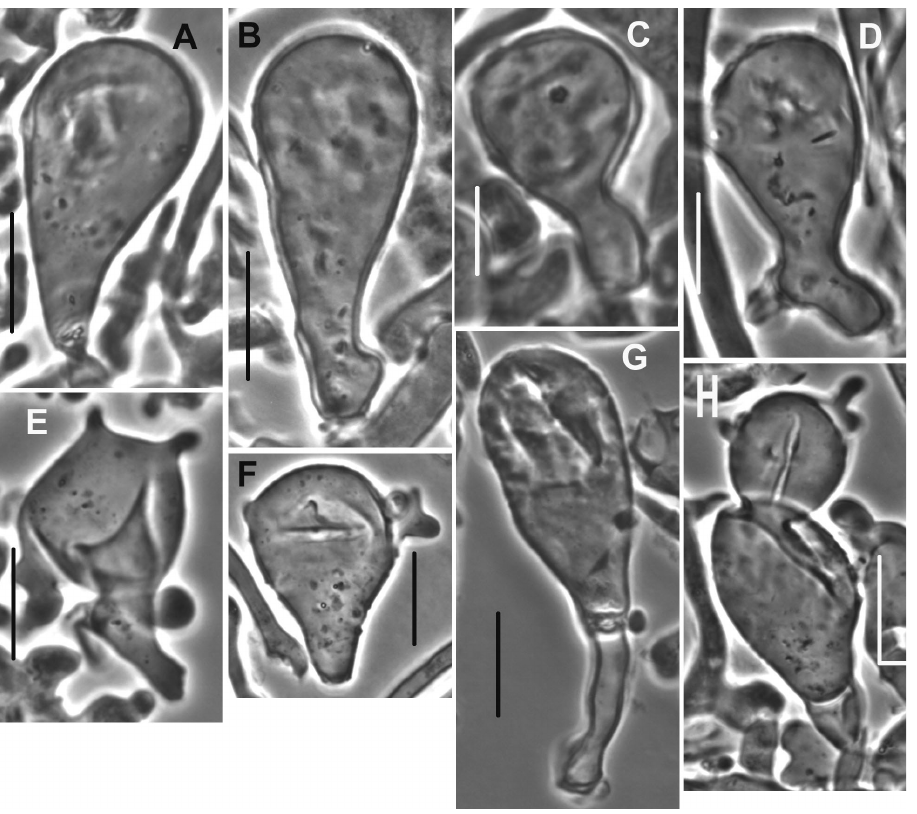
Figure 21. Mycetinis copelandii . Pileipellis elements. A–D, G Broadly clavate individuals without out- growths E, F, H Individuals with lobose outgrowths. Standard bars = 10 µm. TFB 8084